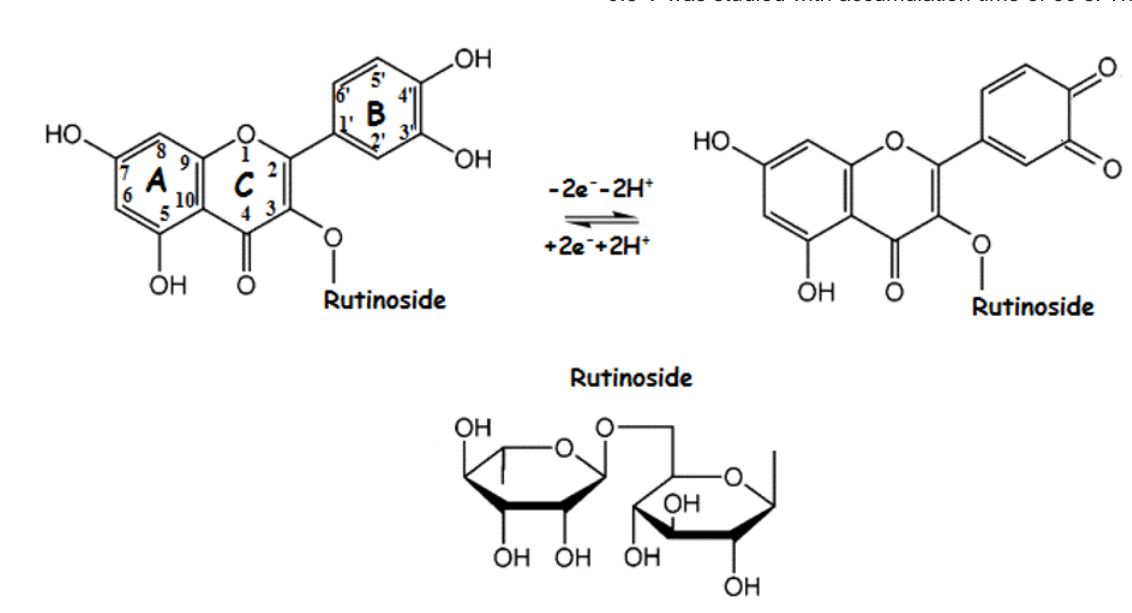
Figure 3. The proposed mechanism for the electrochemical oxidation / reduction of rutin at BDD